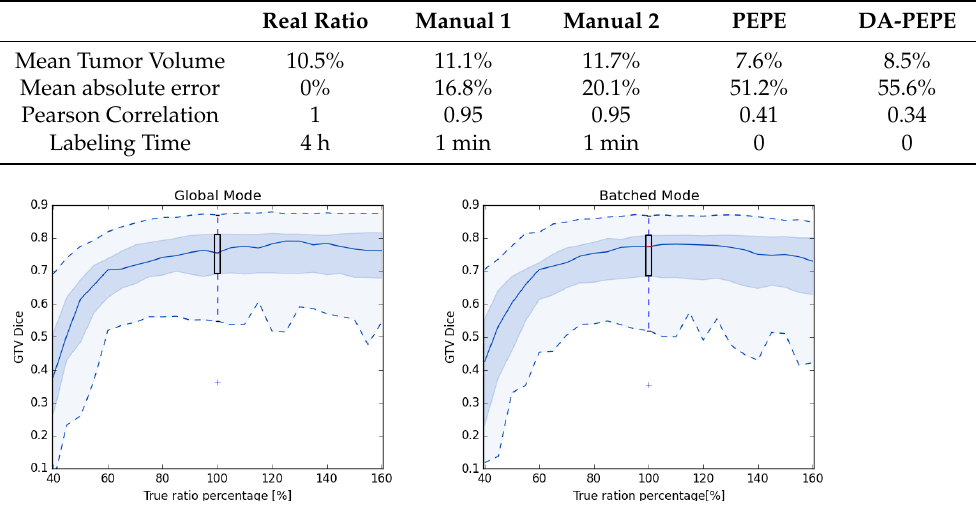
Figure 5. Results of leave-one-out experiments with artificially falsified π . All experiments are conducted with the same random forest tree depth (Global 5 and Batched 4).